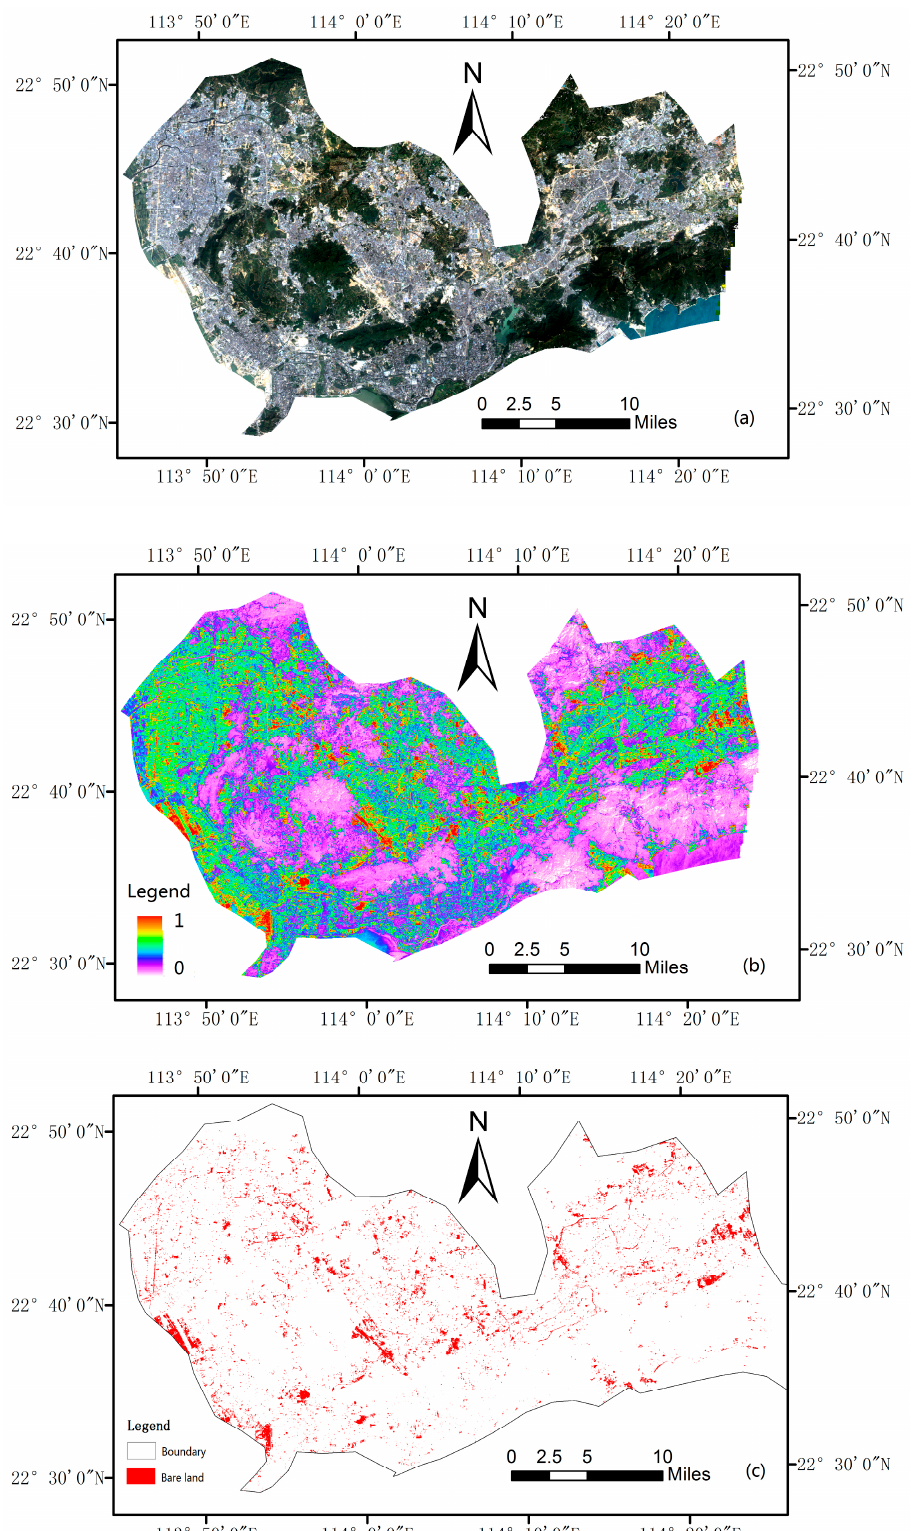
Figure 9. An example in Shenzhen City. ( a ) The Landsat image covering the city on 22 November 2009; ( b ) the NBLI image in color; and ( c ) the extracted bare land in the city.